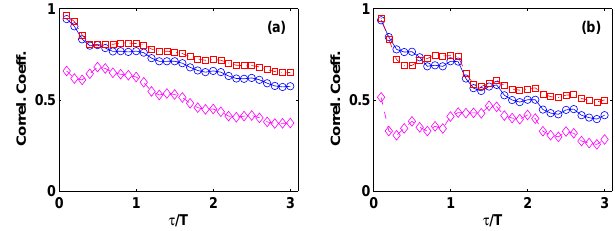
Fig. 4. Correlation coefficients between σ and the Q P parameter (circles), σ and the total strain s 2 = s 2 n + s 2 s (squares), and σ and the flow vorticity − ω 2 (rhombs), as a function of the integration time τ . (a) (cid:15) = 0 . 2 and (b) (cid:15) = 0 . 5. Rest of parameters as in Fig.